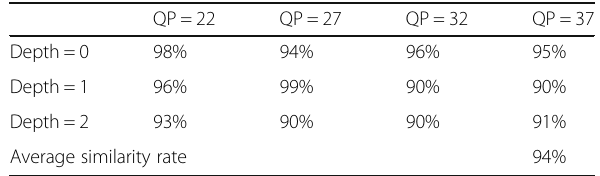
Table 1 Comparison of the division of threshold α and HM 16.16